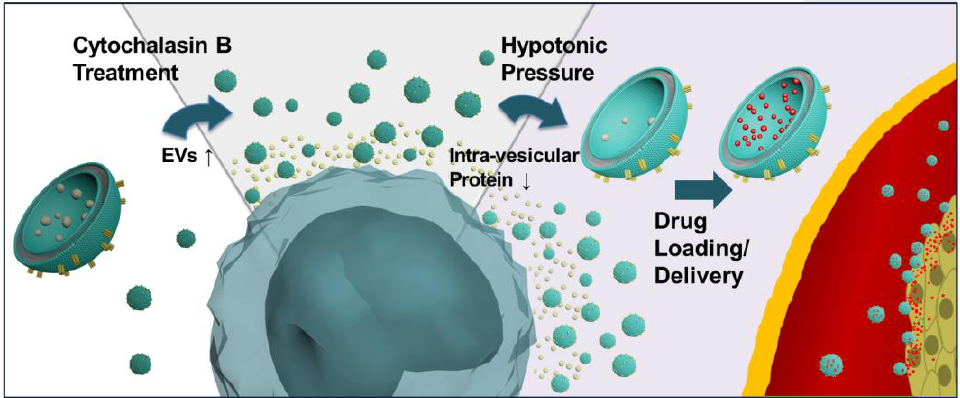
Figure 1. A schematic diagram illustrating the synergistic effect of cytochalasin B treatment and hypo-osmotic pressure for the up-scale of EV production and enhanced drug loading of the pro- duced